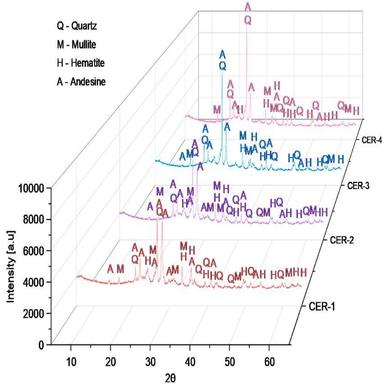
XRD patterns of the obtained ceramsites CER-1, CER-2, CER-3, and CER-4.